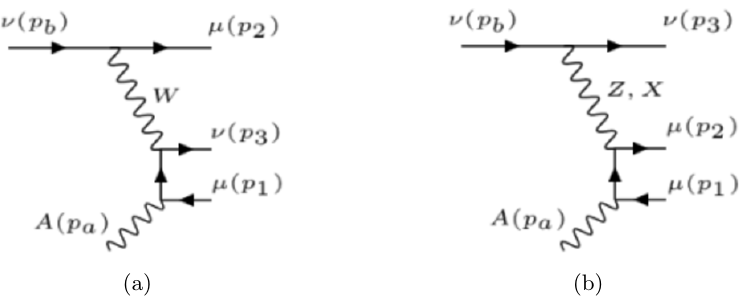
Figure 6 . The trident production in the equivalent photon approximation (EPA). In addition, there are the reciprocal diagrams where the real photon is attached to (cid:22) (cid:0)